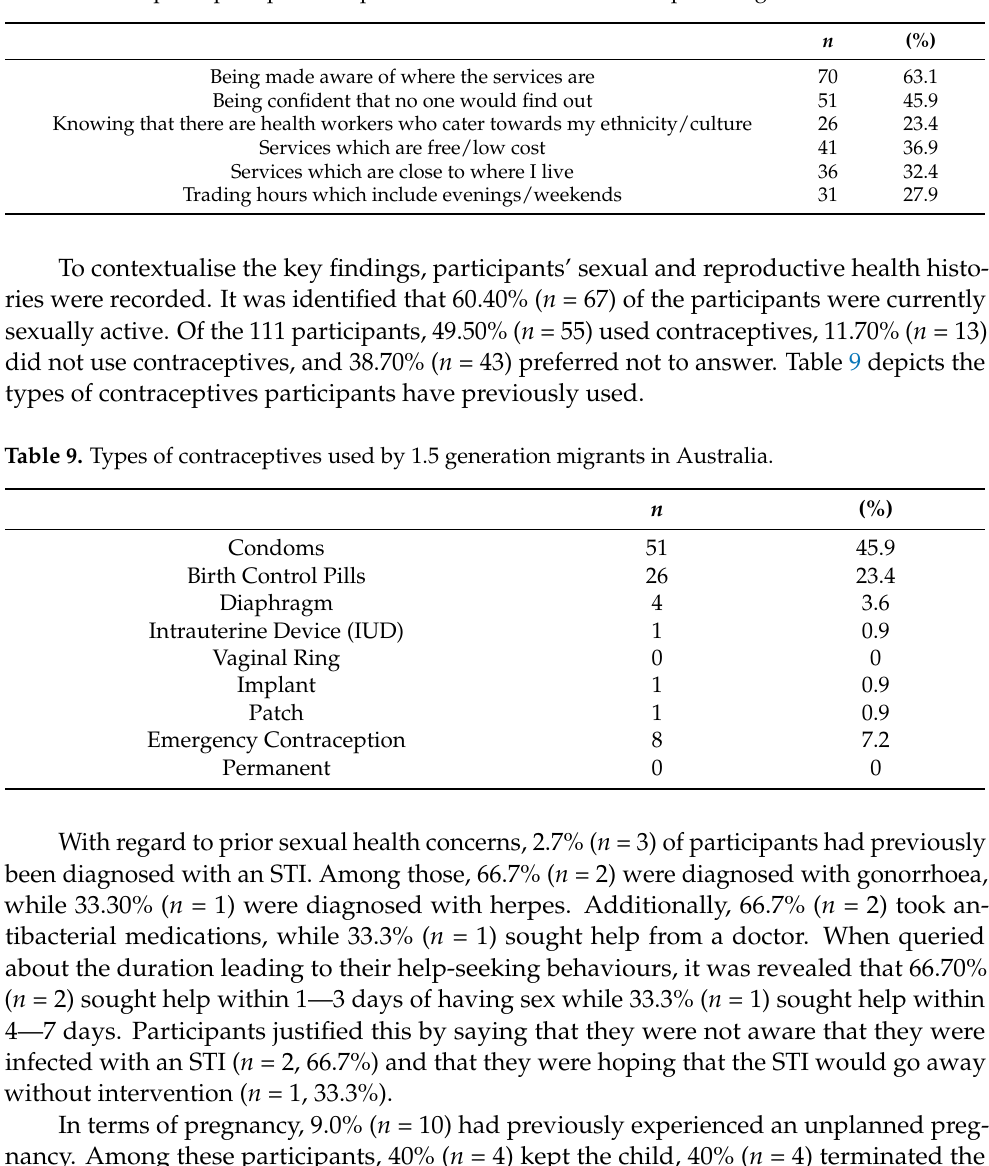
Table 8. Participants perceptions of potential facilitators of SRH help-seeking.